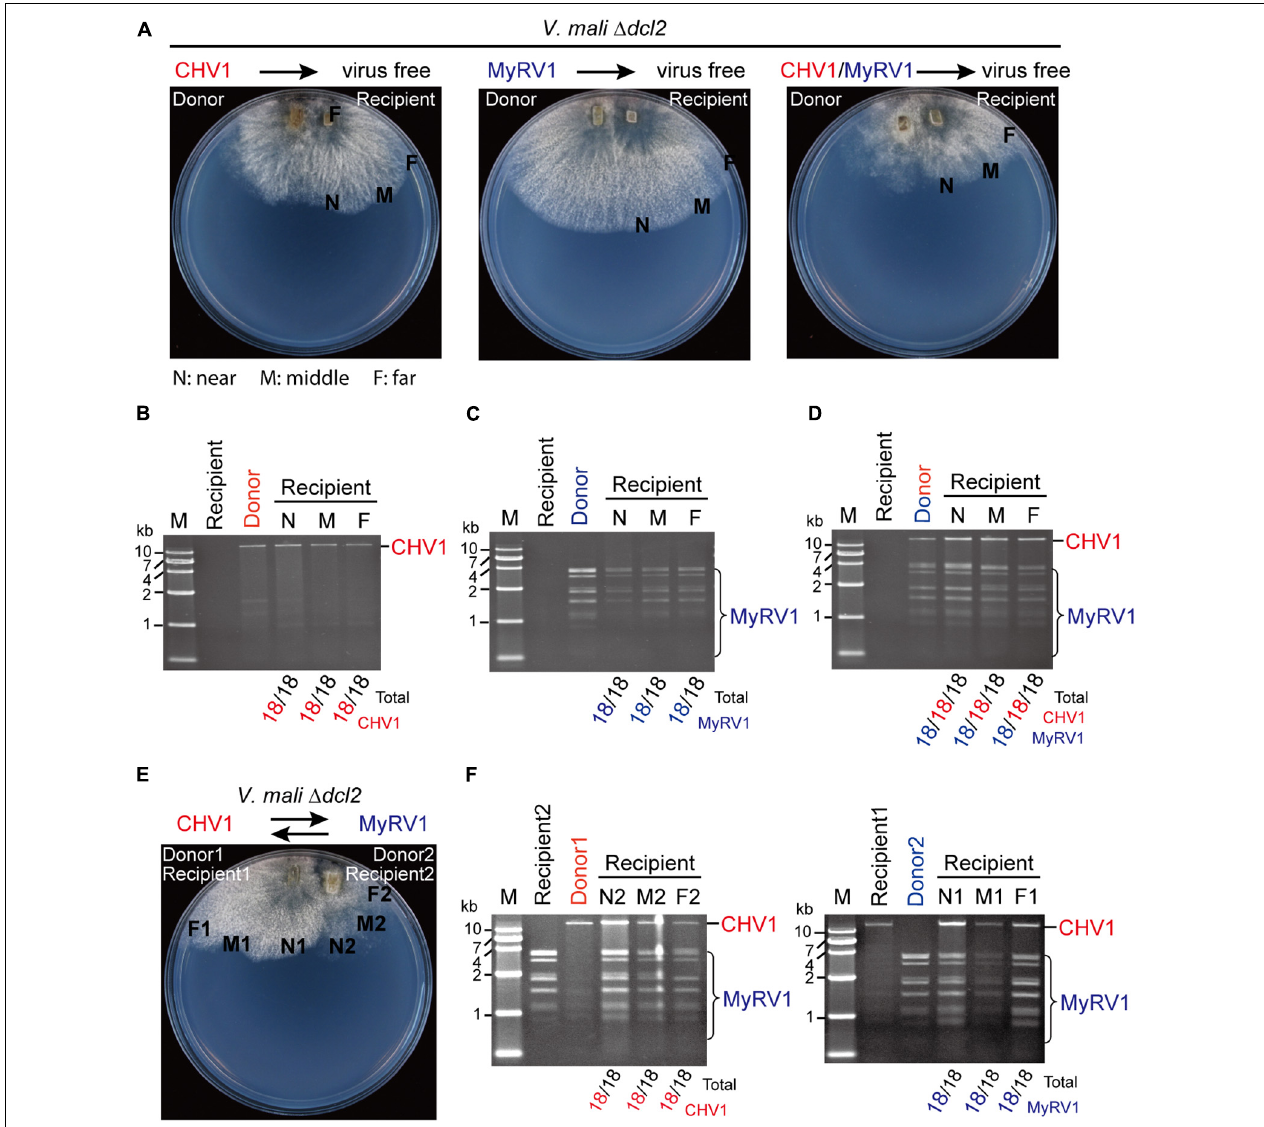
FIGURE 7 | The efficiency of CHV1 and MyRV1 horizontal transmission via hyphal anastomosis in the dcl2 knockout mutant of V. mali . (A) Co-culture on PDA plates of the virus-free V. mali mutant strain and the virus-infected V. mali mutant strain as recipient and donor viruses, respectively. After 1 week of hyphal contact, mycelial plugs were taken from three locations (a near, middle, and far distance from the hyphal fusion areas) in the recipient side, transferred onto new PDA plates and cultured in PDB for dsRNA extraction. (B–D) Detection of viral dsRNAs in recipient strains co-cultured with CHV1-infected (B) , MyRV1-infected (C) , and CHV1 + MyRV1-infected strains (D) . The numbers below the lanes indicate the number of samples in which viral dsRNAs were detected per total number of samples. (E) Co-culture on a PDA plate of CHV1-infected and MyRV1-infected V. mali mutant strains. After 1 week of hyphal contact, mycelial plugs were removed from three locations on both sides, transferred onto new PDA plates and cultured in PDB for dsRNA extraction. (F) Detection of viral dsRNAs in fungal strains obtained in the co-culture experiment described in (E)